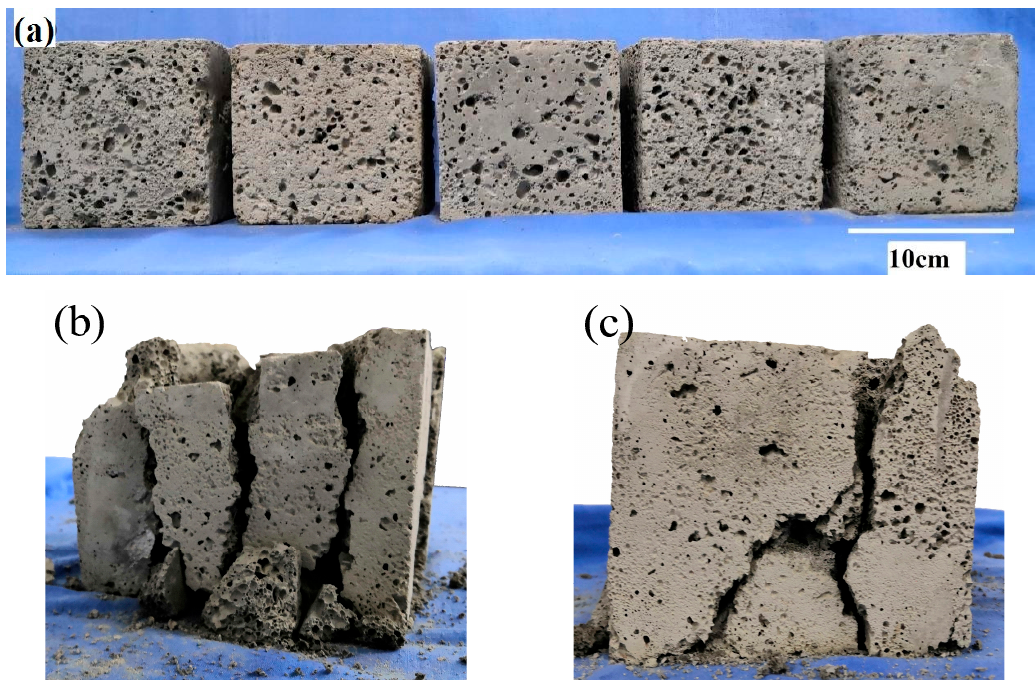
Figure 2. Samples of fly-ash-based foamed geopolymer, ( a ) samples before experiment, ( b ) sample with vertical cracks and ( c ) sample with oblique cracks.